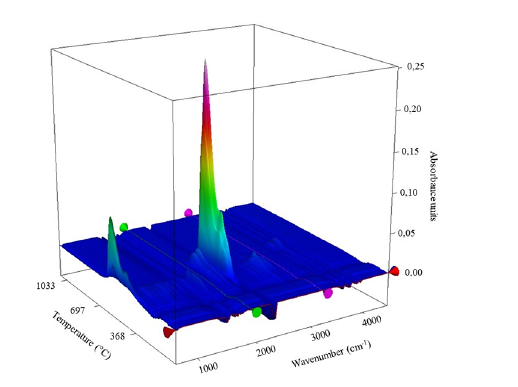
Figure 6. Infrared spectrum of gases resulting from thermal analysis of glass fiber.